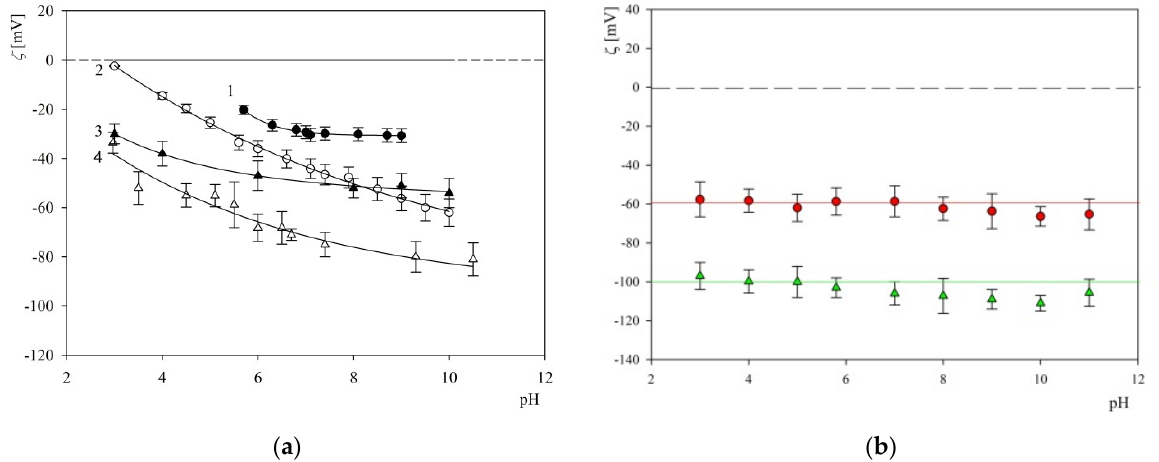
Figure 4. Part ( a ): The dependence of the zeta potential of mica and silica on pH determined by the streaming potential method: line 1—silica, 150 mM NaCl, line 2—silica, 10 mM NaCl, line 3—mica, 150 mM NaCl [28], line 4—mica, 10 mM NaCl. The solid lines represent fits of experimental data. Part ( b ): The dependence of the zeta potential of PS particles on pH determined by the LDV method. ( ● ) 150 mM NaCl, ( ▲ ) 10 mM NaCl. The solid lines represent fits of experimental data.